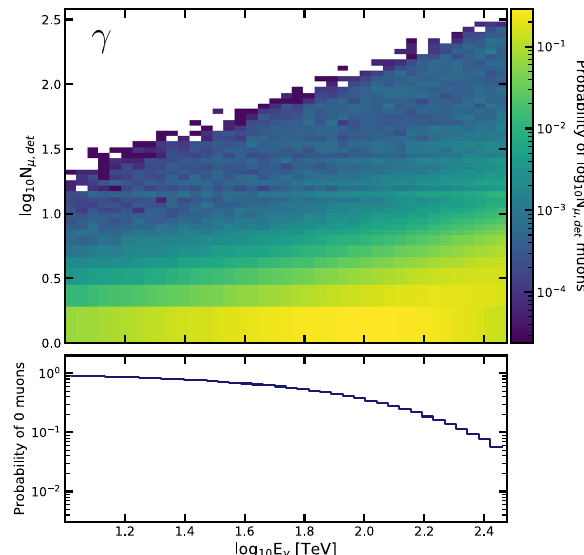
on the top left corner. Bottom panel: Probability of 0 muons in a shower vs primary energy. Normalised together with the upper panel at each energy